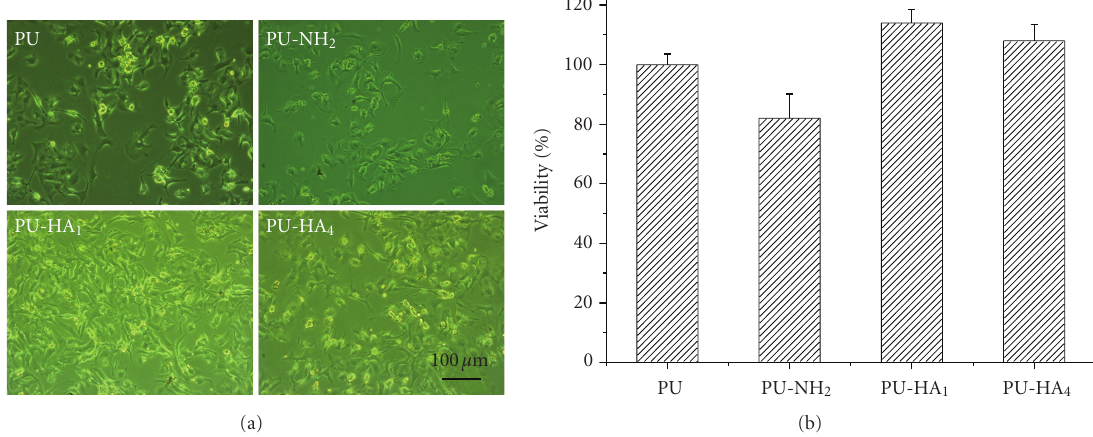
Figure 8: Phase contrast images of HUVECs attached on the surface of PU, PU-NH 2 , PU-HA 1 and PU-HA 4 7 days postseeding. There is a significant di ff erence ( P < .05) between PU and PU-NH 2 , PU-HA 1 , PU-HA 2 . No significant di ff erence is between PU-HA 1 and PU-HA 2 . The scale bar in the micrograph of PU-HA 4 stands for 100 μ m and it is applicable for all micrographs in the